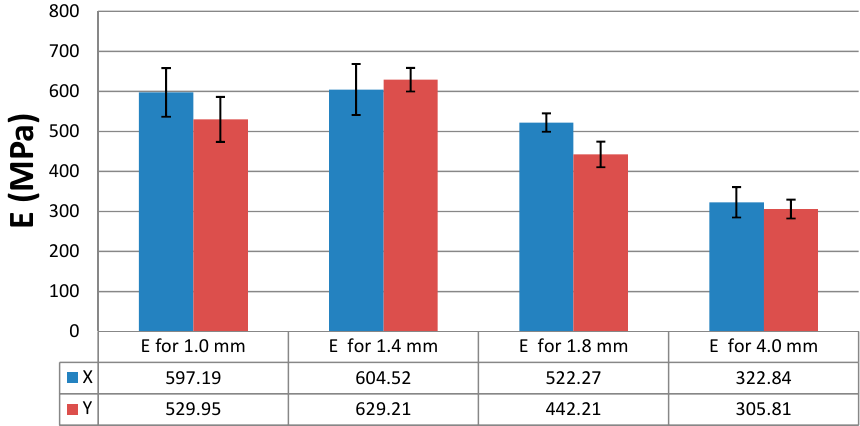
Figure 14. Modulus of elasticity, E, of the PLA + bronze specimens, depending on their thickness and the printing orientation.